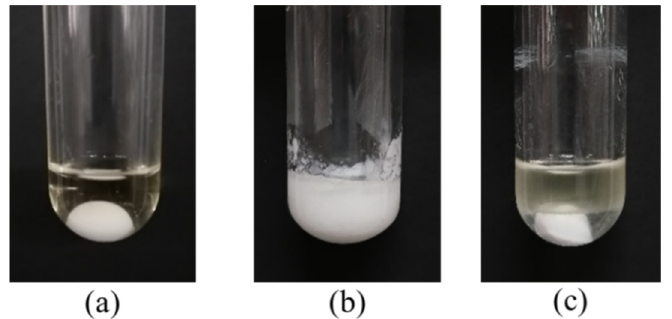
Figure 7. Phenomenon of DBSA-catalyzed esterification of oleic acid with cetyl alcohol. ( a ): no water added, ( b ): 100% water added, ( c ): saturated CaCl 2 solution added. Reaction conditions: a reaction temperature of 60 °C, DBSA 10 mol% DBSA, a molar ratio of 1.3:1 oleic acid to alcohol, a reaction time of 4 h and 100 wt% water of cetyl alcohol.